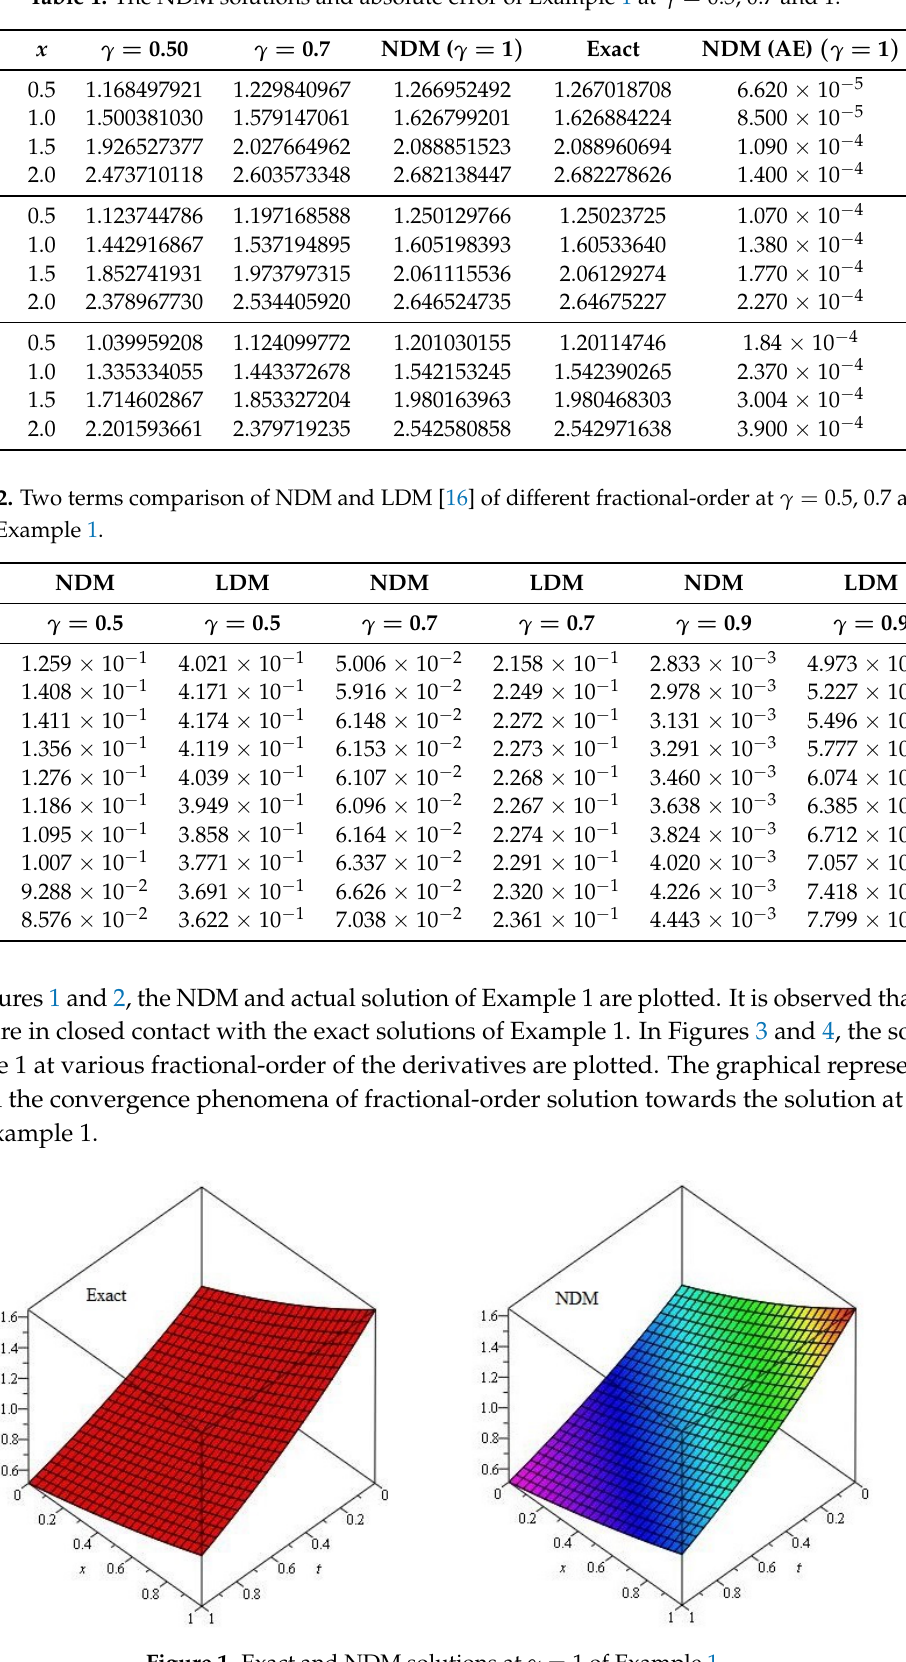
Table 1. The NDM solutions and absolute error of Example 1 at γ = 0.5, 0.7 and 1.